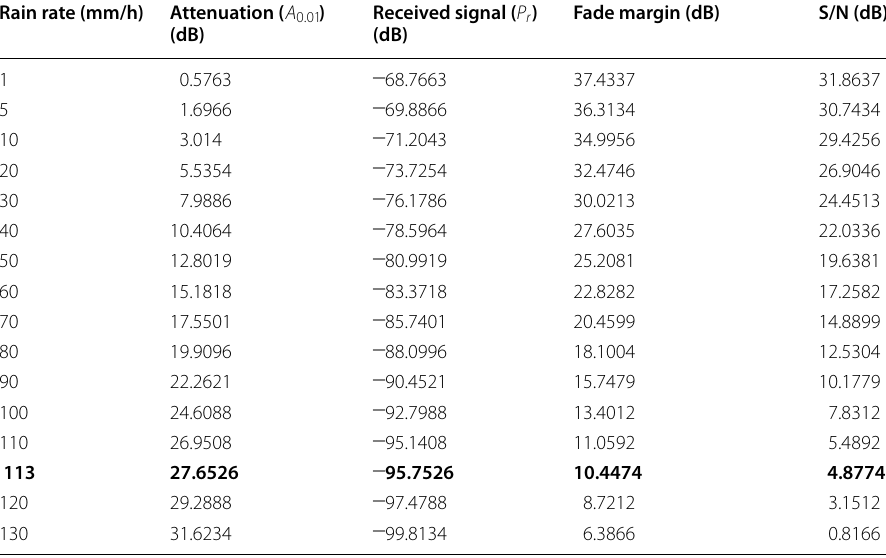
Table 6 Rain attenuation related results